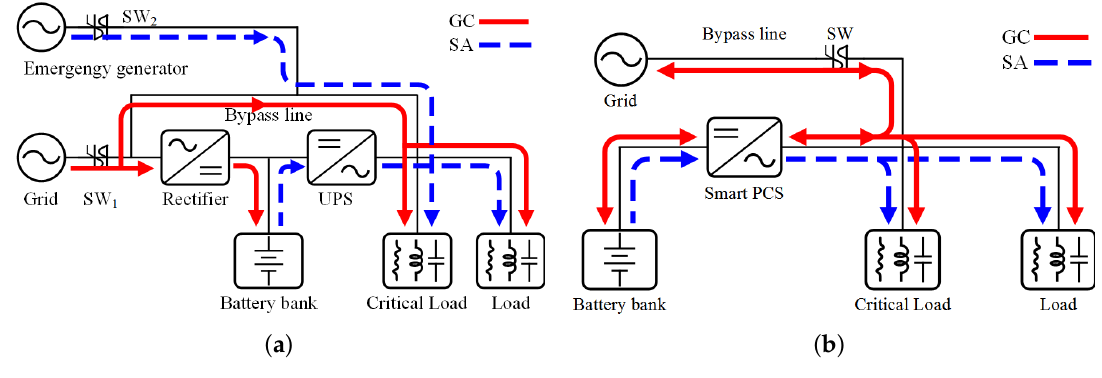
Figure 2. Operation power flow of ( a ) conventional UPS ( b ) proposed PCS.